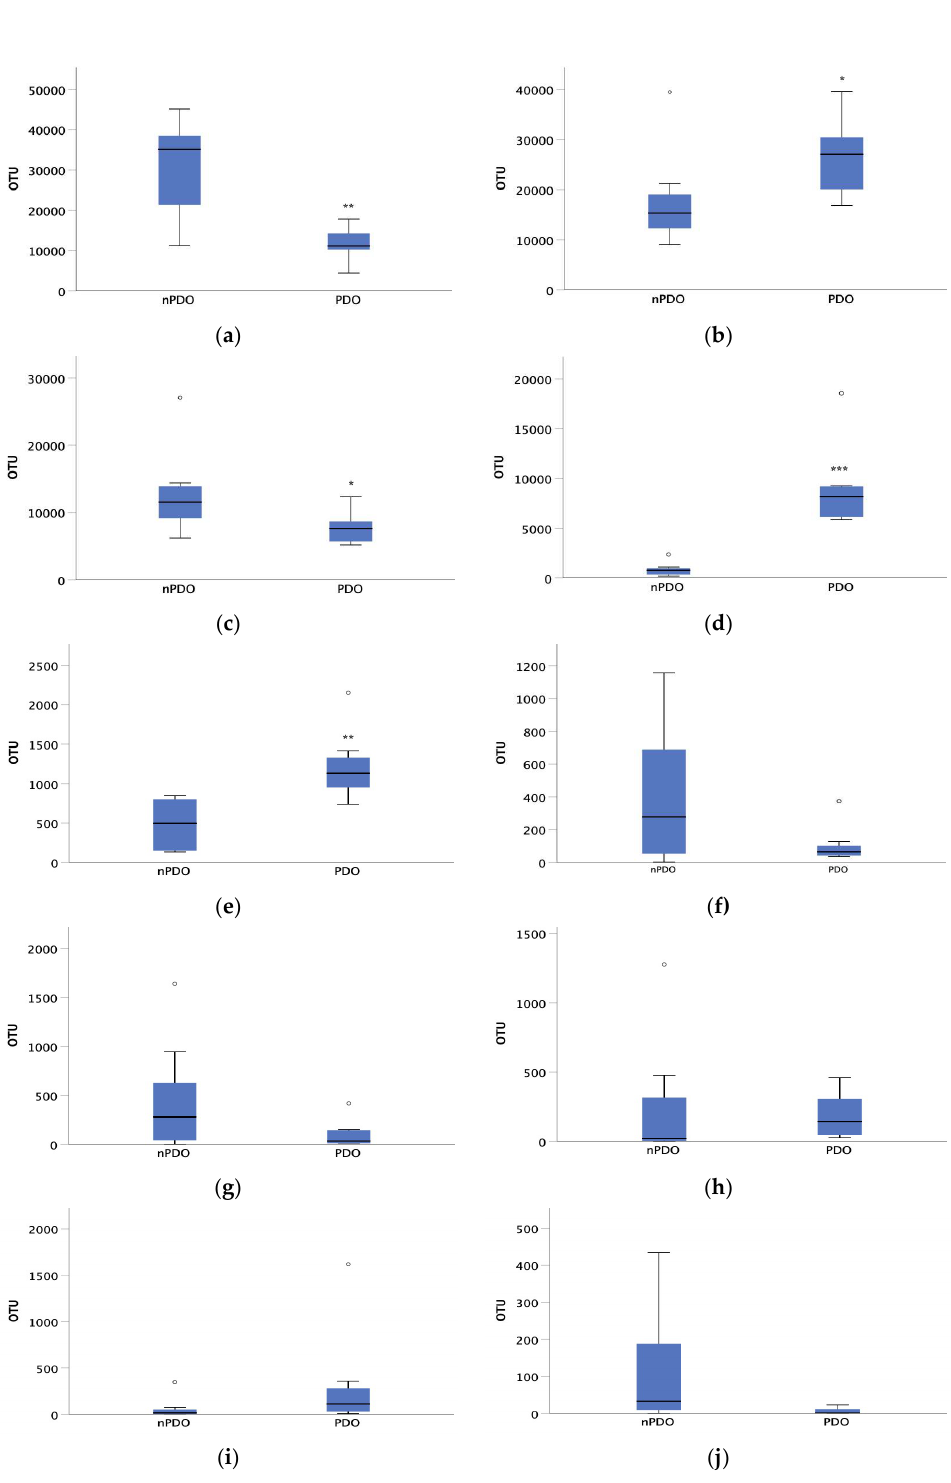
Figure 5. Comparison of OTUs identified at the genus level between samples of non-PDO cheese (nPDO) and PDO cheese. The genera compared were: ( a ) Streptococcus , ( b ) Lactobacillus , ( c ) Lactococcus , ( d ) Leuconostoc , ( e ) Enterococcus , ( f ) Staphylococcus , ( g ) Pediococcus , ( h ) Macrococcus , ( i ) Weissela and ( j ) Serratia . * p < 0.05, ** p < 0.01, *** p < 0.001.